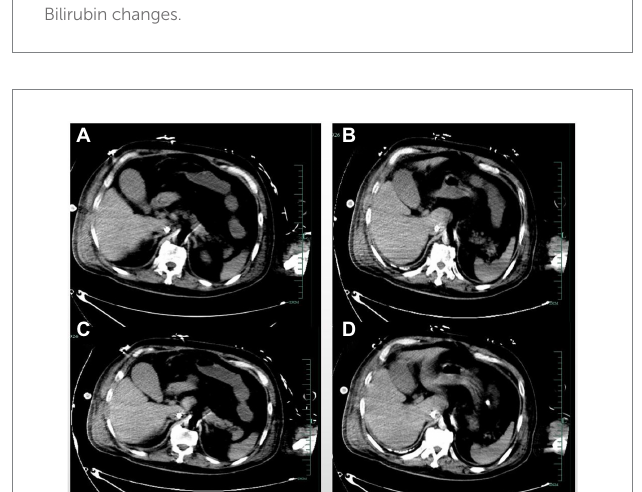
FIGURE 1 Bilirubin changes.